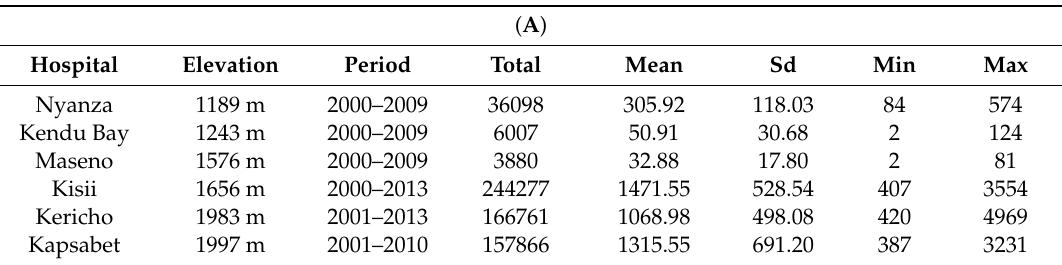
Table 1. Summary of statistics. ( A ) Monthly number of malaria cases and elevation of each hospital. ( B